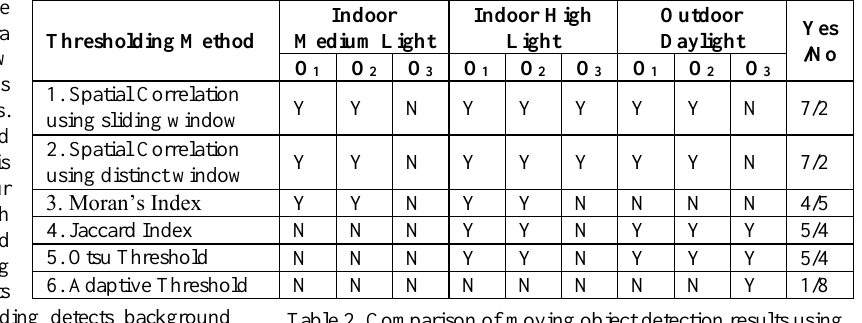
Table 2. Comparison of moving object detection results using six different techniques of image thresholding